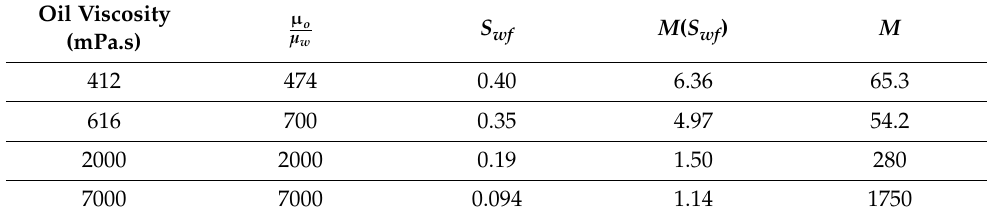
Figure 17. Summary of the matched fractional flow curves (f w *) for the 4 water flooding cases simulated in this work. Table 6. Water saturations, finger mobilities and end point mobility ( M ) for the 4 water flooding cases. Oil Viscosity